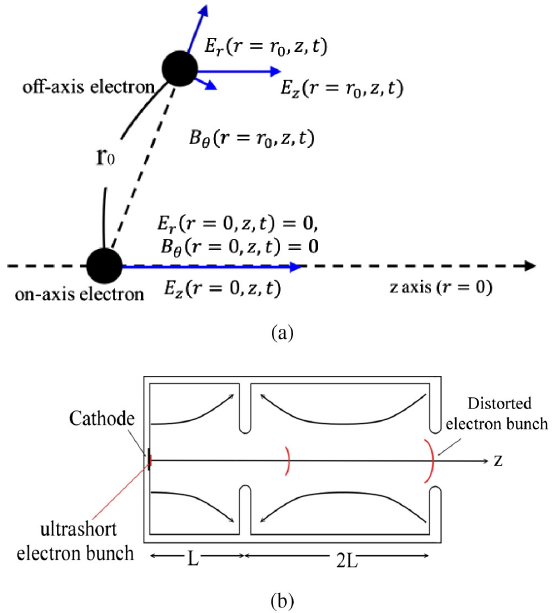
FIG. 2. (a) An on-axis electron sees only a longitudinal tudinal and transverse field components. (b) Simultaneously